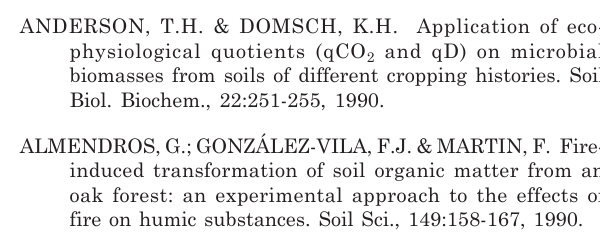
Table 4. Enzymatic activity, absolute values, and specific activity (values in parentheses) in control soil (mineral fertilization) and sewage sludge-treated soils 230 days after application